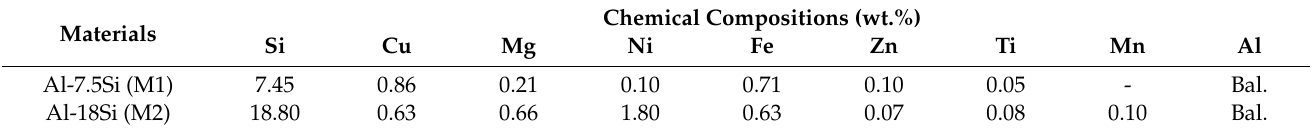
Table 1. Chemical compositions of the materials